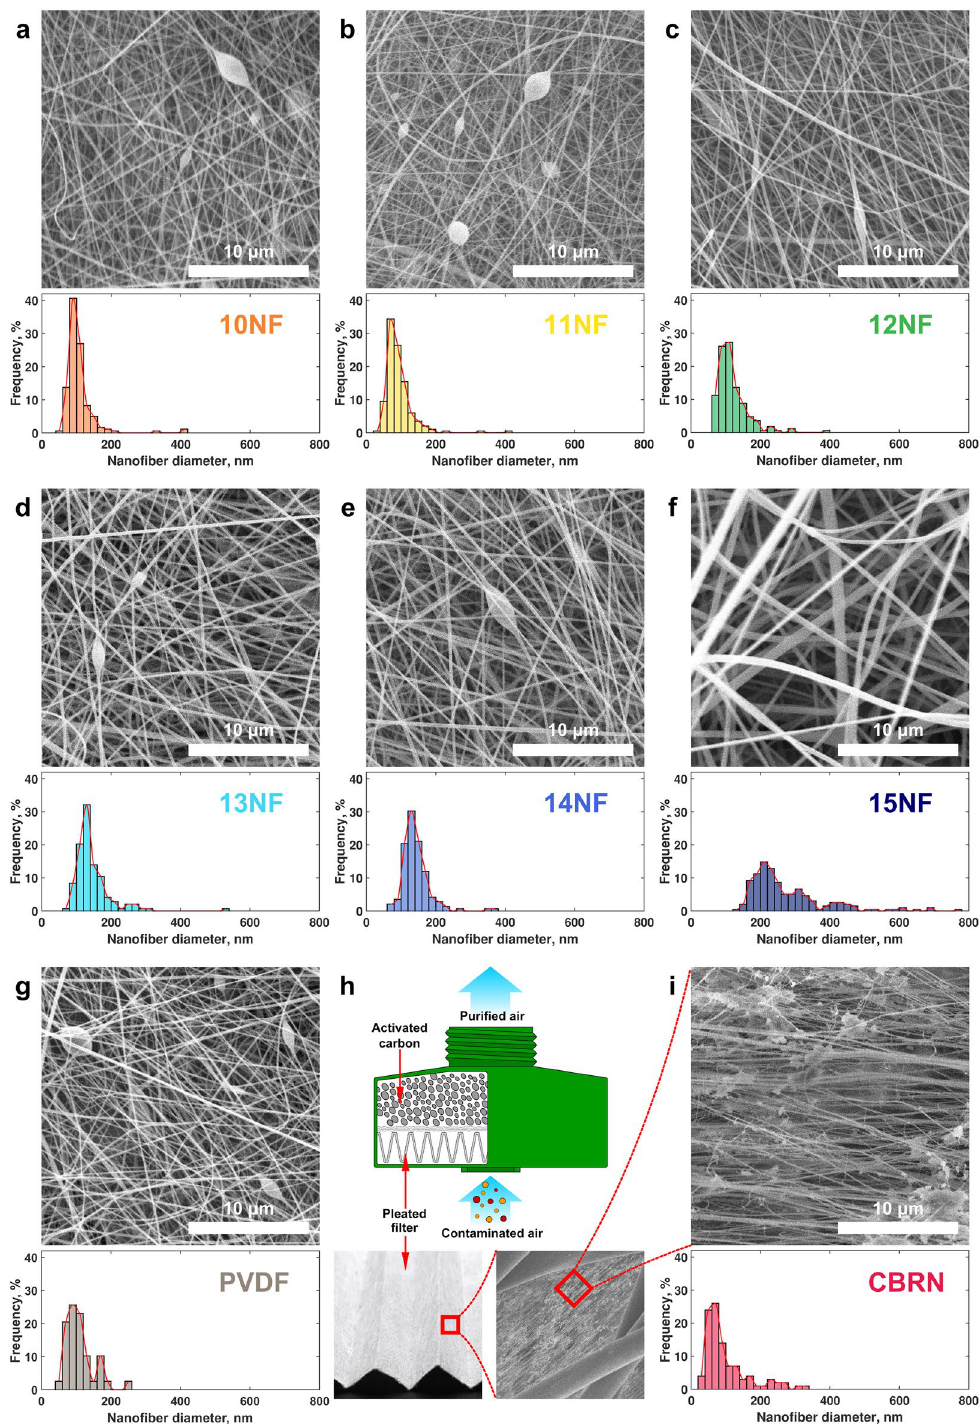
Figure 2. Microstructure of the aerosol filters: ( a–g,i ) scanning electron micrographs and nanofiber diameter distribution in the nanofibrous filters 10NF, 11NF, 12NF, 13NF,14NF, 15NF, PVDF, and the commercial CBRN filter, respectively; ( h ) schematics of the commercial filter canister and the photos of the pleated filter